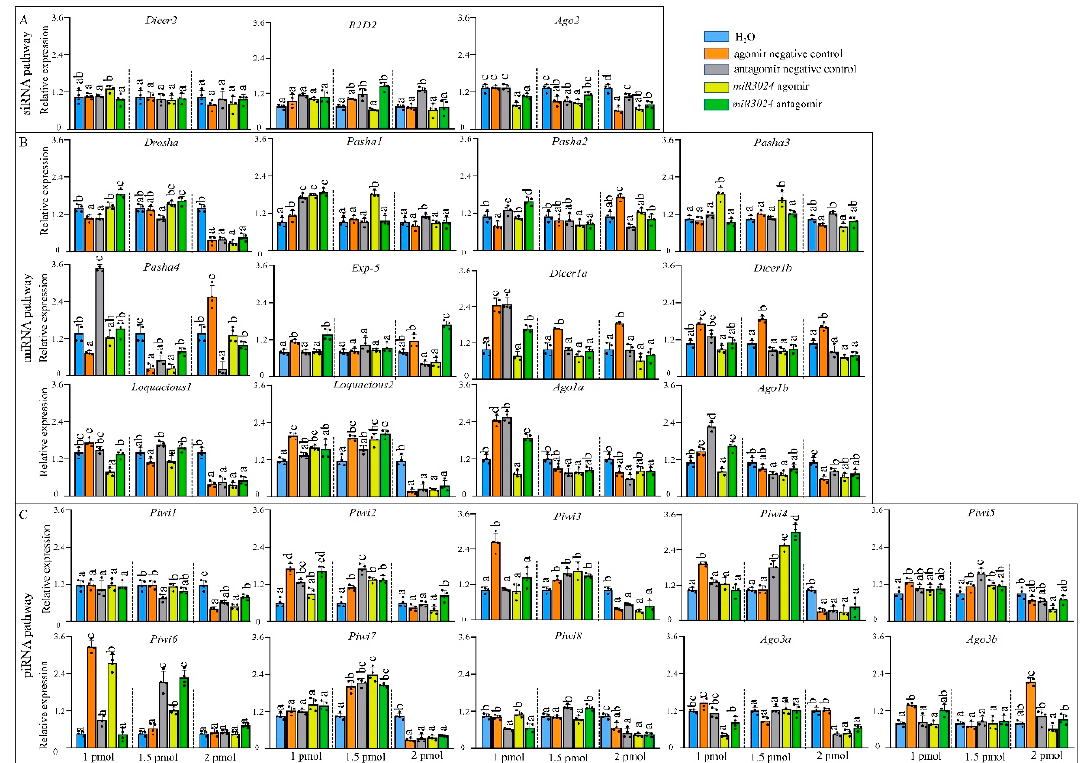
Figure 4. Expression profiles of core genes of three RNAi pathways after miRNA agomir/antagomir administration by microinjection. ( A ) siRNA pathway. ( B ) miRNA pathway. ( C ) piRNA pathway. Different colors represent different change levels. Mean (±SE) expression level is based on four biological replicates. The relative expression was normalized based on two reference genes, A. pisum elongation factor-1 alpha ( EF1a ) and ribosomal protein S2-like RPS2 . Lowercase letters above each bar indicate significant differences (one-way ANOVA followed by Tukey’s honestly significant difference multiple comparison test; p < 0.01). agoNC: agomir negative control; antNC: antagomir negative control; ago3024: mi-R3024 agomir; ant3024: miR-3024 antagomir. The Significant difference was analyzed in each dosage, independently. 1 pmol: 15.4 ng (agomir), 8 ng (antagomir); 1.5 pmol: 23.1 ng (agomir), 12 ng (antagomir); 2 pmol: 30.8 ng (agomir), 16 ng